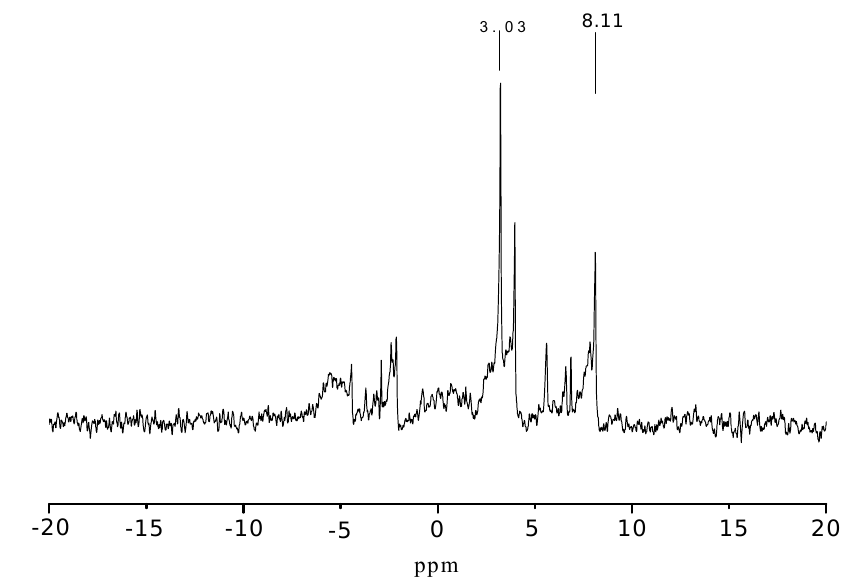
Figure 5. 31 P-NMR spectrum of phosphorus-containing triazine oligomer